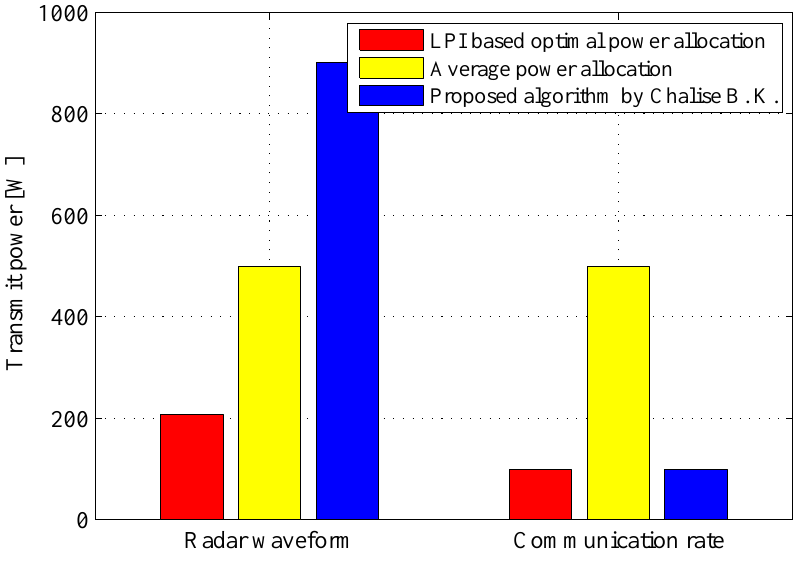
Figure 6. Comparisons of transmit power for radar waveform and communication rate employing different algorithms ( P Total = 1000 W, δ D = 0.9, δ FA = 10 − 6 , γ rad = − 10 dB, γ com = − 5 dB, r th = 5